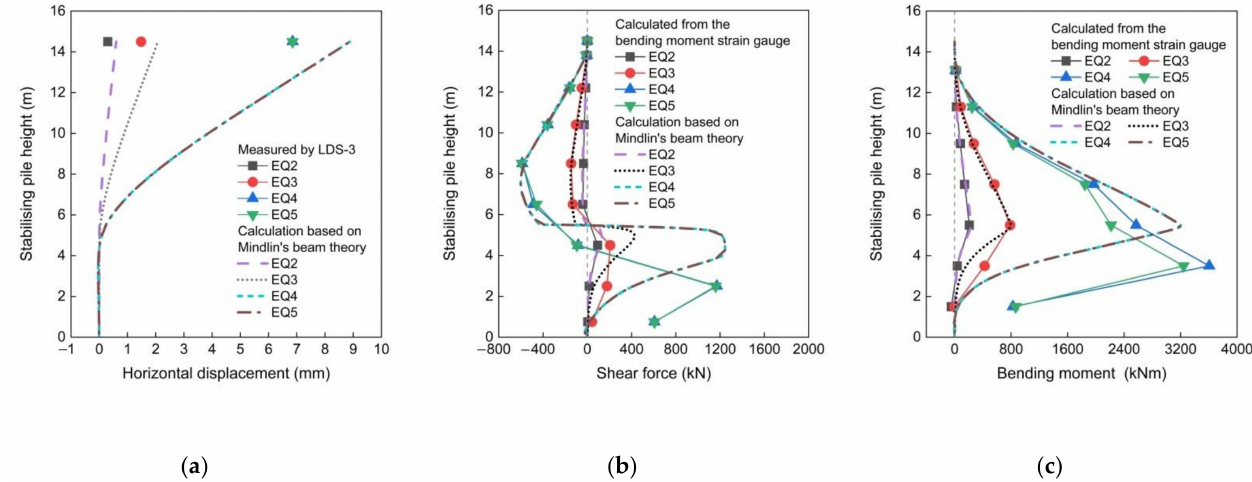
Figure 20. Comparison of the calculated results after test–measurement conversion and the calculated results based on Mindlin beam theory for a stabilizing pile after each shaking event: ( a ) horizontal displacement; ( b ) shear force; ( c ) bending